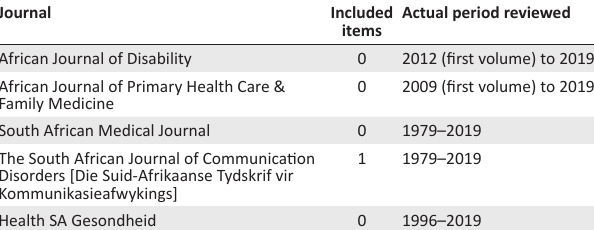
TABLE 2: Included journals with identified data